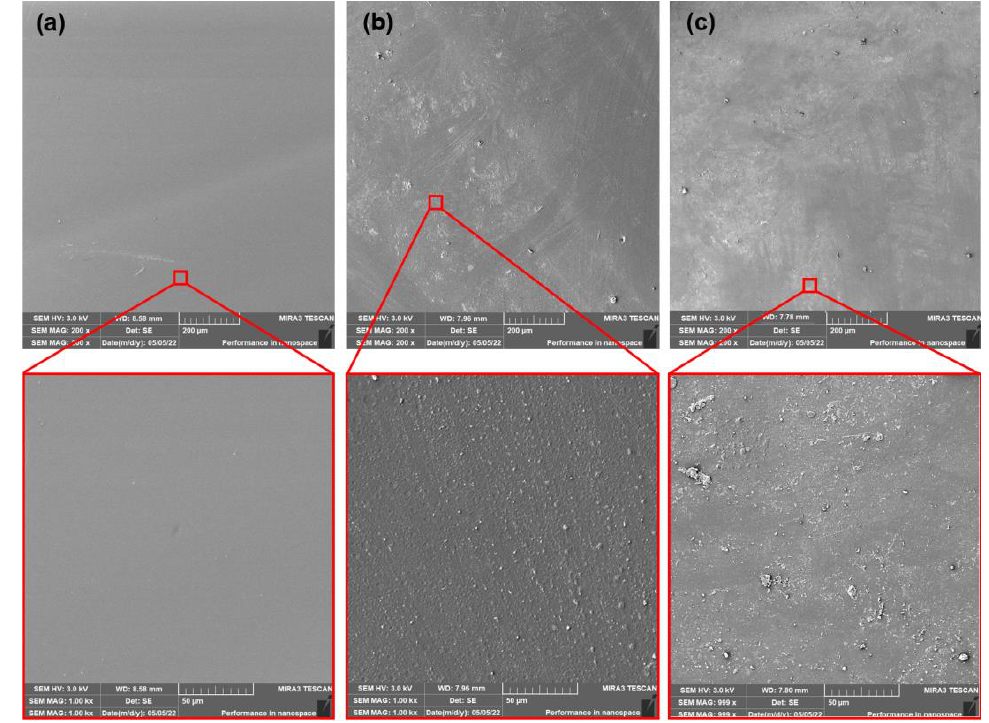
Figure 9. SEM images of aged PLA/ATBC films ( a ) at initial state and after ( b ) 14 days of thermophilic composting, and ( c ) 28 days of thermophilic composting.